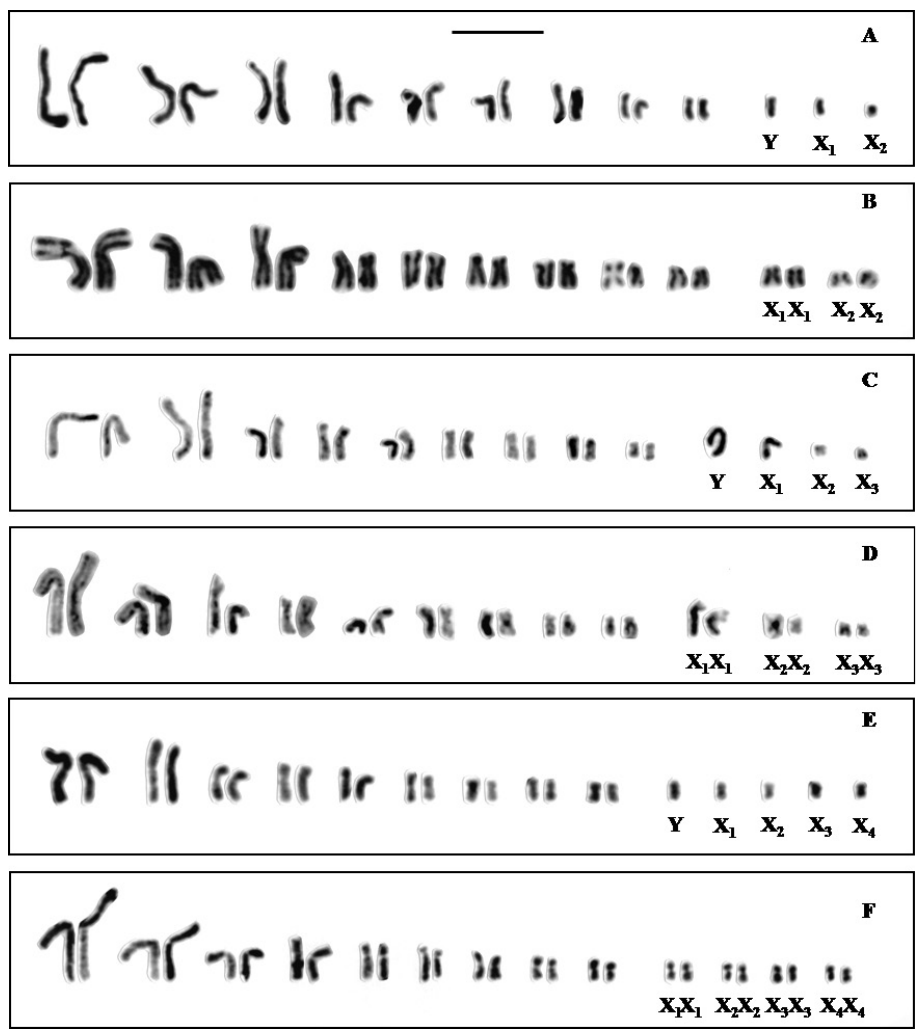
Figure 1a–f. Standard karyotypes of a C. hispanica male b C. hispanica female c C. maura male d C. maura female e C. trisignata male and f C. trisignata female. Bar =